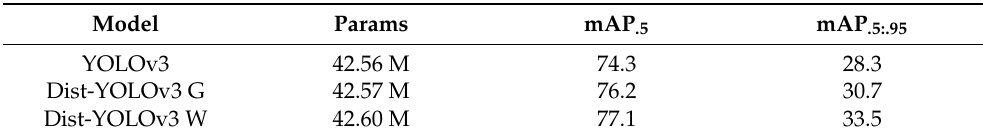
Table 1. Measurement of bounding box precision detection. ‘YOLOv3’ represents result for the original YOLOv3 implementation. ‘Dist-YOLOv3 G’ is the result for our class-agnostic approach, and ‘Dist-YOLOv3 W’ is the result for our class-aware